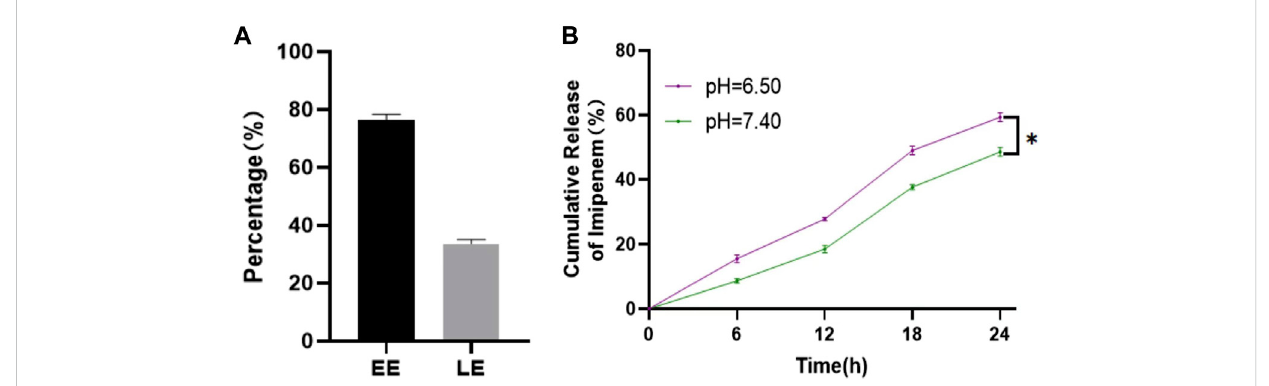
FIGURE 2 Drug loading and release rate of Imi@ZIF-8. (A) EE and LE of Imi@ZIF-8. (B) Cumulative release rates of imipenem from Imi@ZIF-8 at different pH values (6.5 and 7.4). Data are presented as means ± SD ( n = 3). Intergroup comparisons: * p <